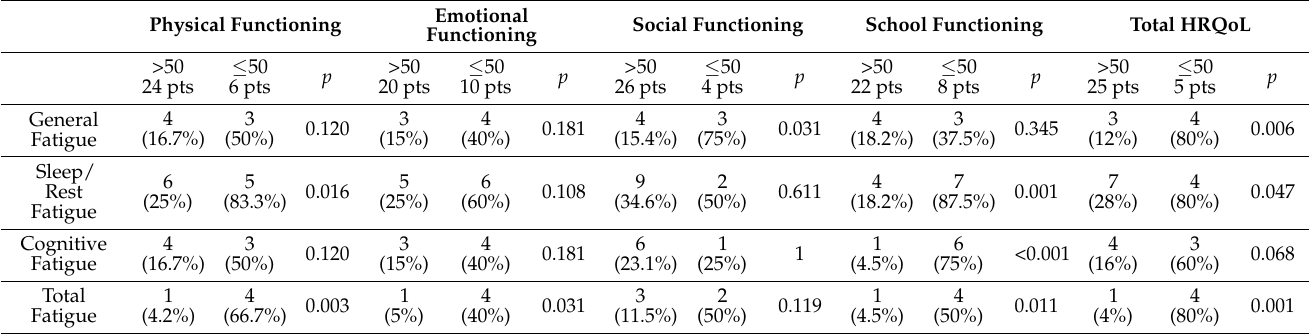
Table 3. Association between low fatigue (score ≤50) and health-related quality of life (HRQoL) scores.